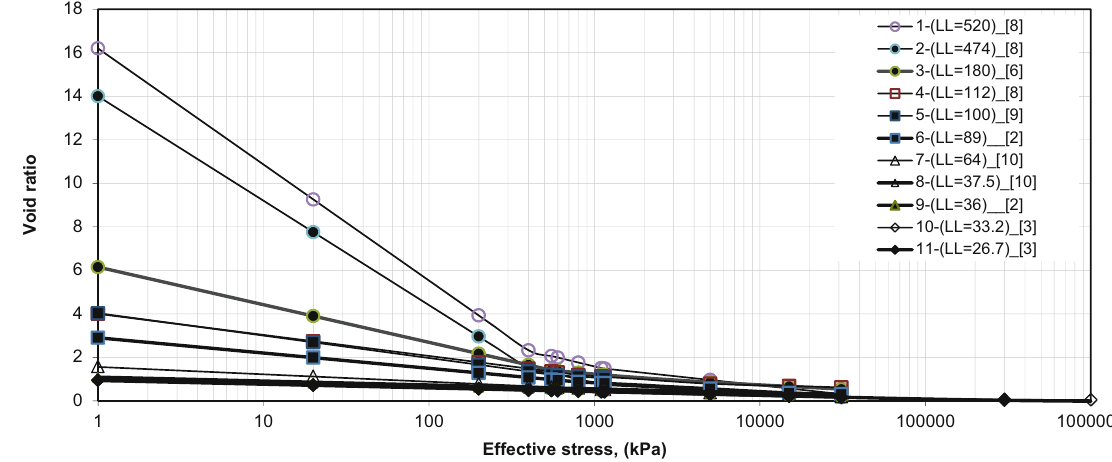
Figure 1: The complete 1D - NCL for 11 soils used in this study.